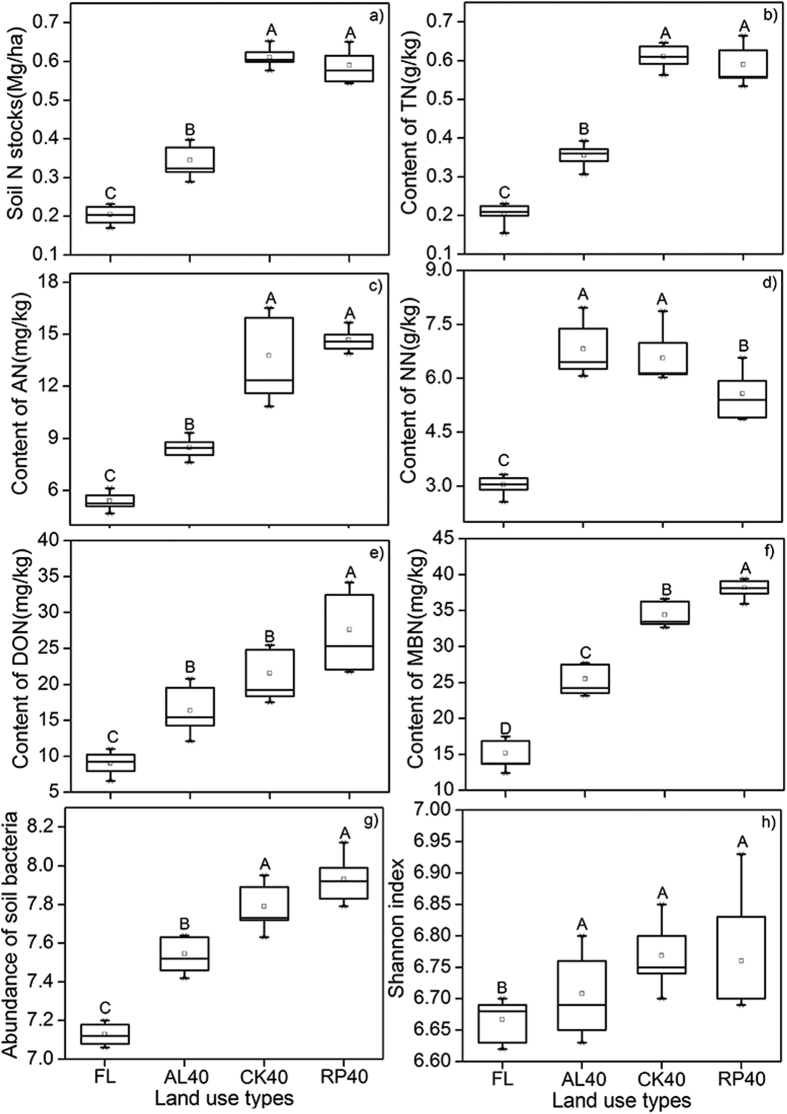
Changes of soil nitrogen (N) stocks, soil nitrogen (N) fractions.Different capital letters indicate significant differences among different land use types (P < 0.05). The error bars show standard errors.